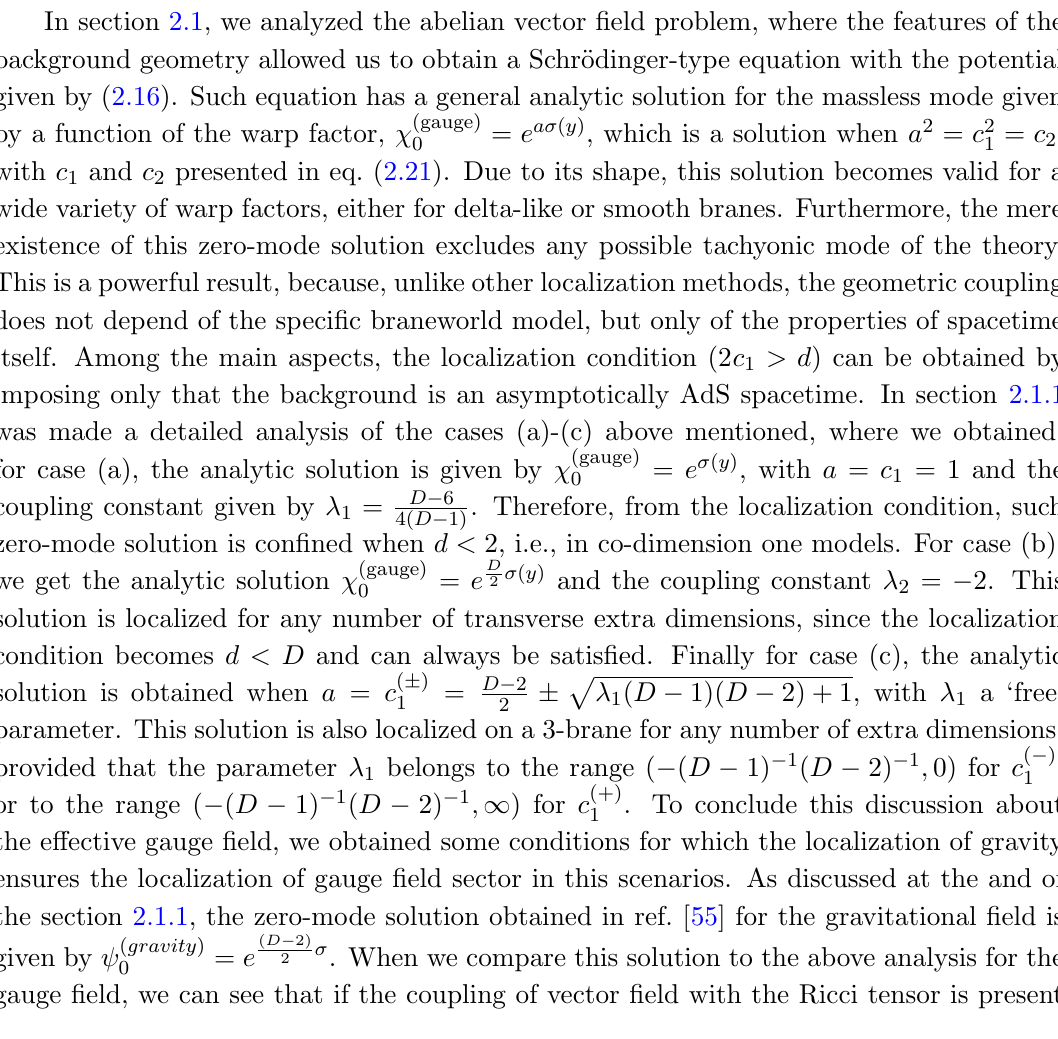
(scalar (cid:12)elds) was separated in some particular k